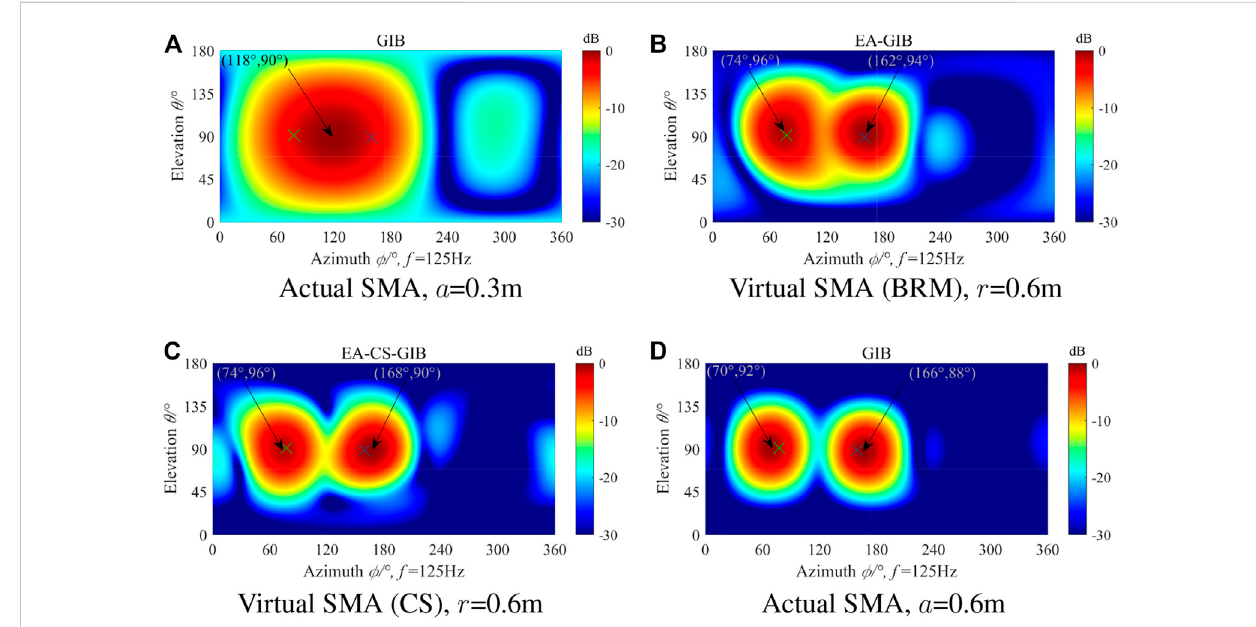
FIGURE 9 The simulation results for double sources localization and identi fi cation usingthevirtualSMAin (B) and (C) at125 Hzand SNR = 20dB, andusing the actual SMA shown in (A) and (D) for comparison purposes.